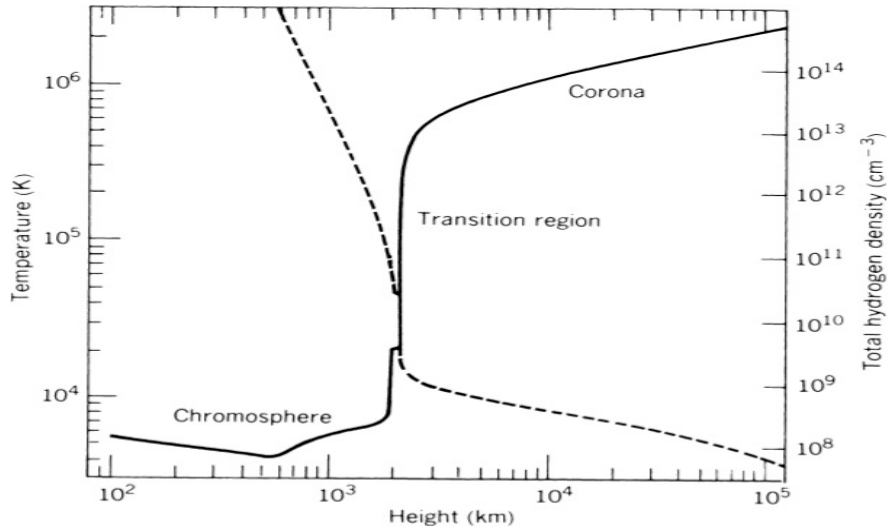
Figure 8. The solar corona density (dashed curve) and temperature (solid curve) plot taken from Withbroe (1981)